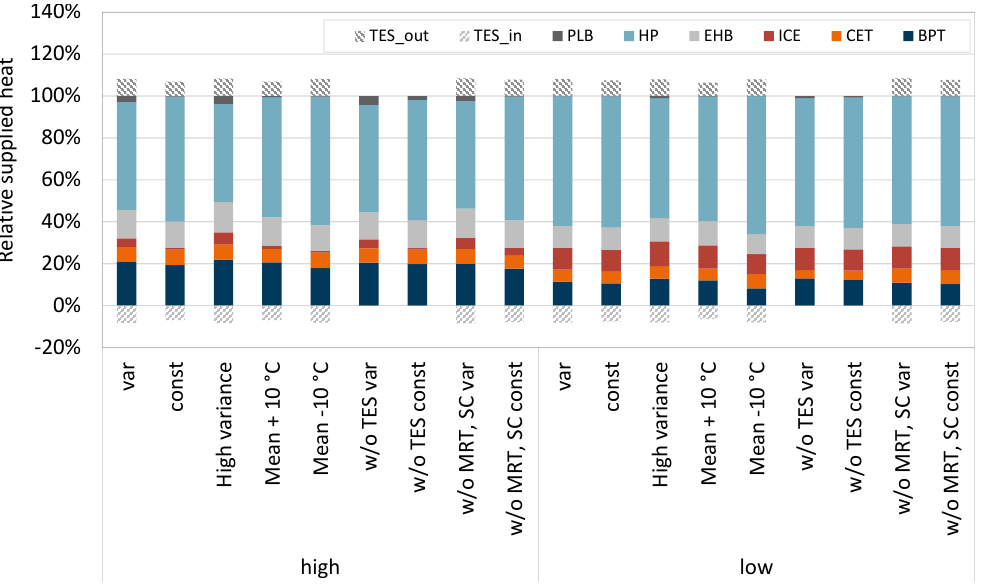
Figure 8. Analysis of annual heat supply for additional PTH scenarios and different sensitivities (MRT—minimum runtimes; SC—start